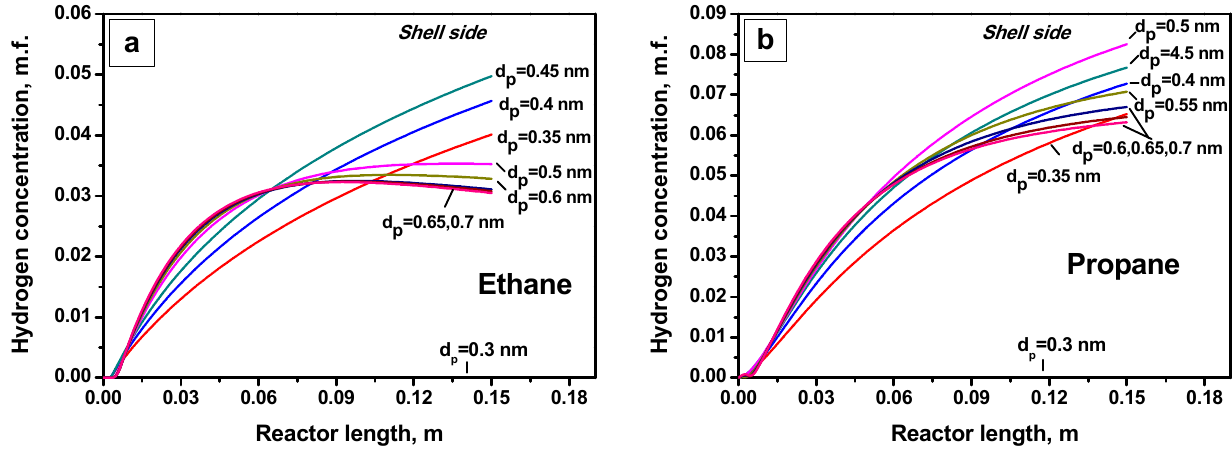
Figure 2. Hydrogen concentration profiles vs. reactor length for various diameters of the membrane pores: ( a ) ethane dehydrogenation; ( b ) propane dehydrogenation.